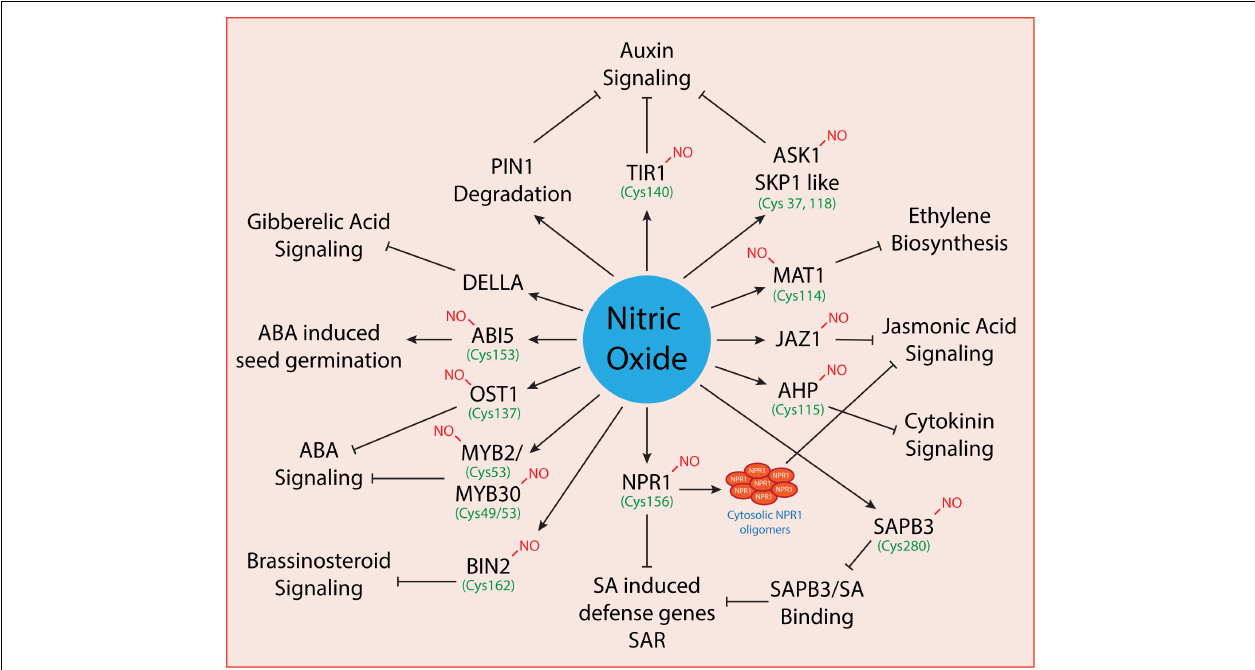
FIGURE 2 | Regulation of phytohormonal network by nitric oxide. Some of the known proteins involved in phytohormonal signaling that are directly modulated by nitric oxide have been shown here. However, only a few are known to undergo S-nitrosylation (where the cysteine residues have been indicted with green color) while others need to be explored